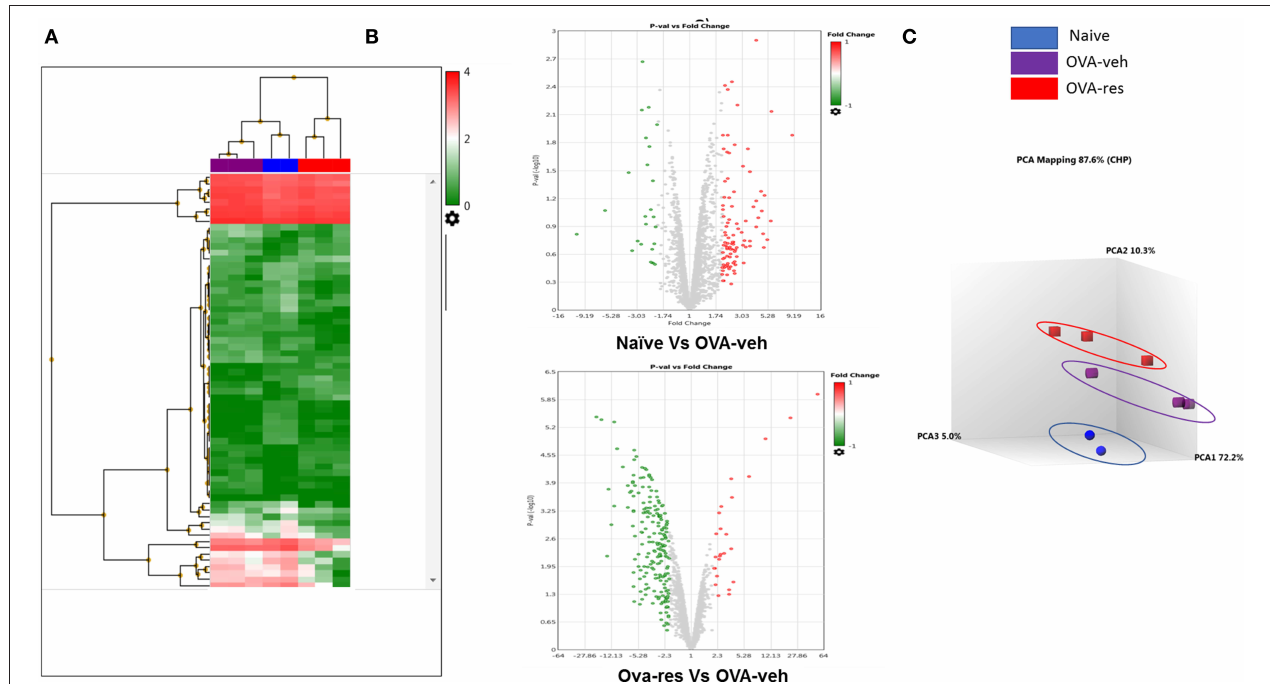
FIGURE 3 | Resveratrol treatment alters miRNA profile in lung infiltrating cells. OVA-induced asthmatic mice were treated with resveratrol as described in Figure 1. Lung infiltrating cells from naïve, OVA-veh, and OVA-res groups were isolated and total RNAs including miRNAs were used to perform miRNA arrays. (A) Heat map showing miRNAs expression profile with red representing upregulated while blue representing downregulated miRNAs. (B) Volcano Plot shows that OVA-res group has higher levels of downregulated miRNAs when compared to OVA-veh group. (C) Principal component analysis (PCA) plot showing separation of miRNA in the three groups. The number of mice used (Naïve: n = 3, OVA-veh: n = 3, and OVA-res: n = 3).